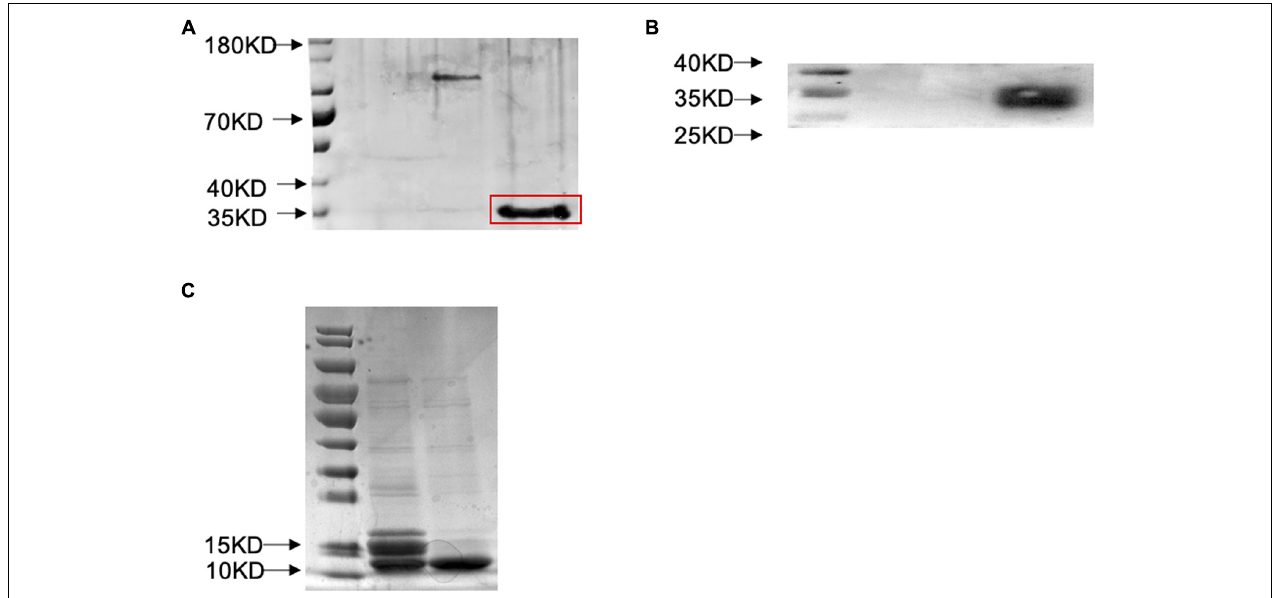
FIGURE 3 | Prokaryotic expression and western blot verification of SlitOBP11. (A) SDS-PAGE was used to detect the expression of SlitOBP11 with His-tag after induction with IPTG and purification by Ni-NTA column [The band is highlighted by a red box, and the tags were from pET32a(+), which has a label of about 20 KD.]. (B) Western blot was used to confirm the results of purification; well 2 shows the SlitOBP11 and well one is blank. (C) SDS-PAGE was used to detect the SlitOBP11 after cleavage of the His-tag (The first electrophoresis Lane, enterokinase was used to cleave the His-tag) and purification by Ni-NTA column (The second electrophoresis